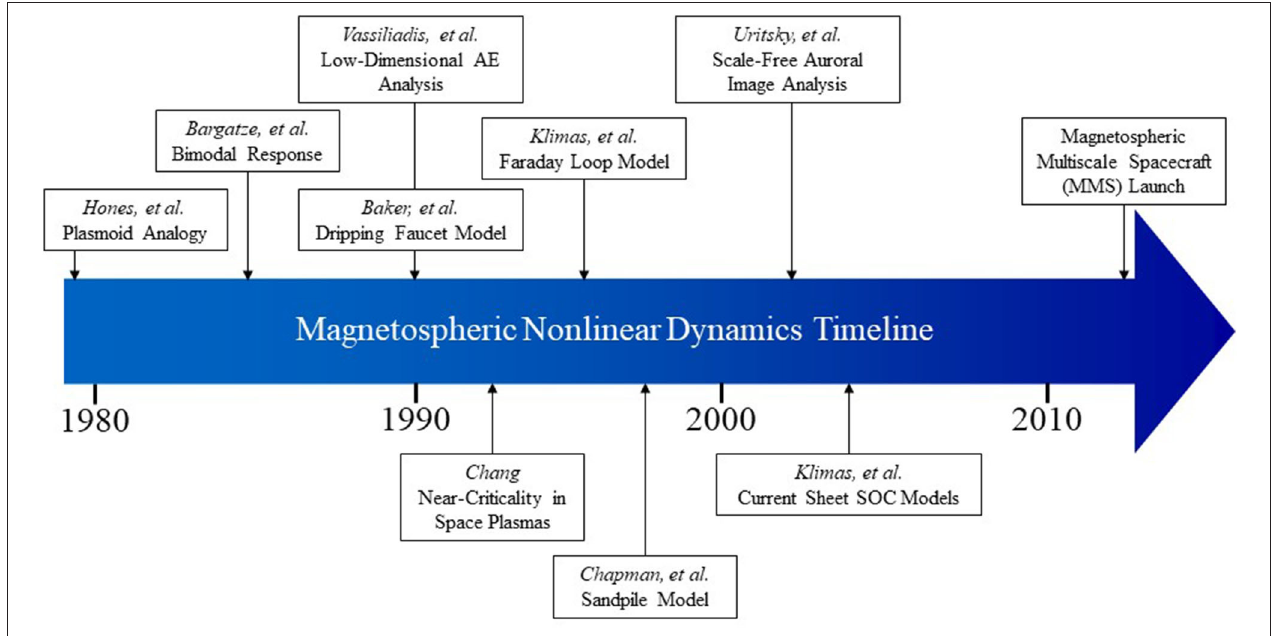
FIGURE 11 | A timeline of ideas and papers dealing with various aspects non-linear dynamics in magnetospheric physics (from Baker,